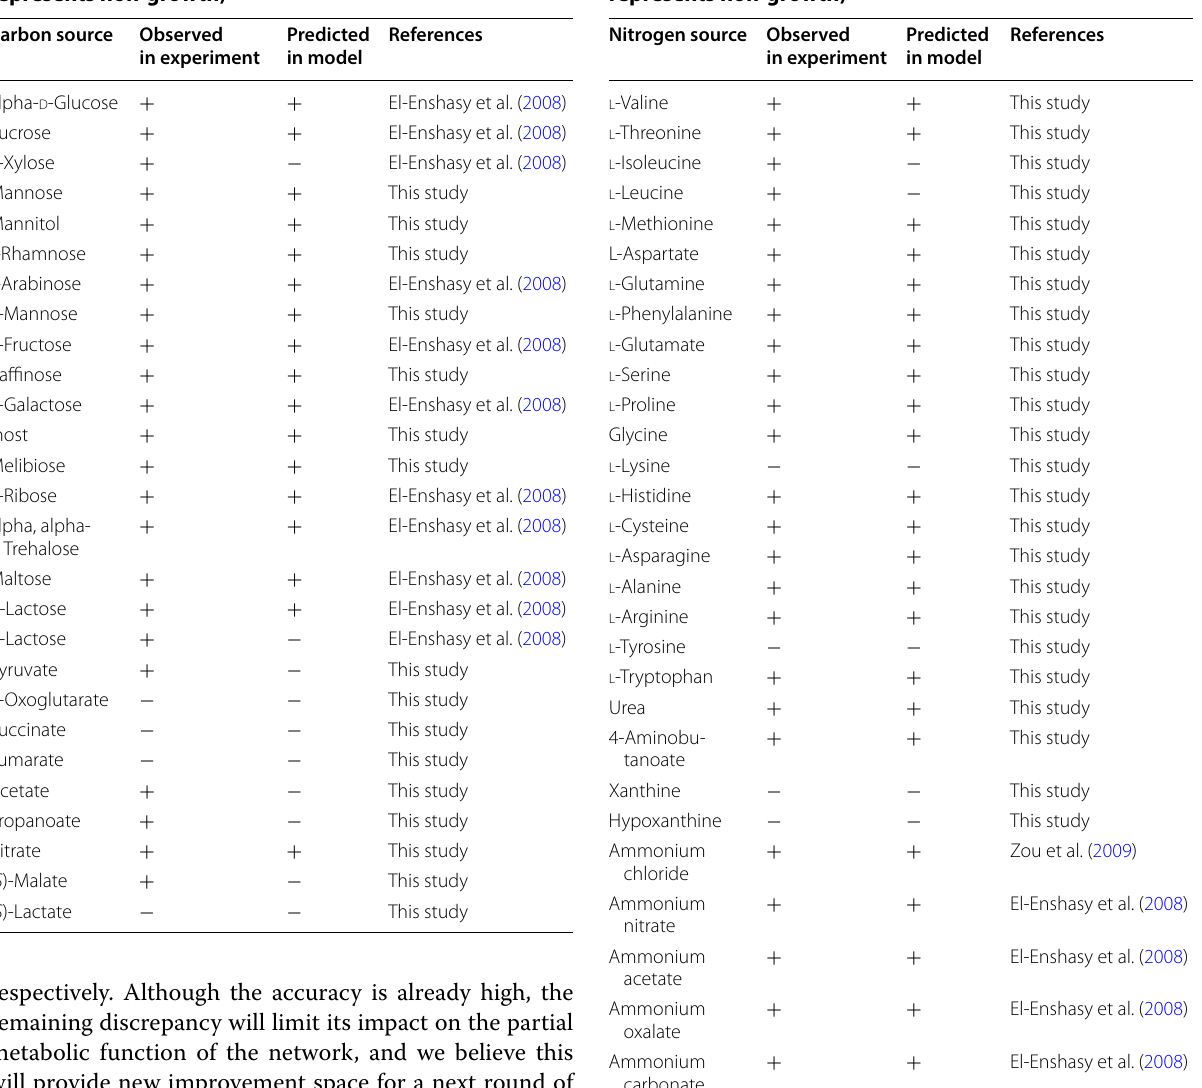
Table 3 Prediction of growth capability of represents growth and + −